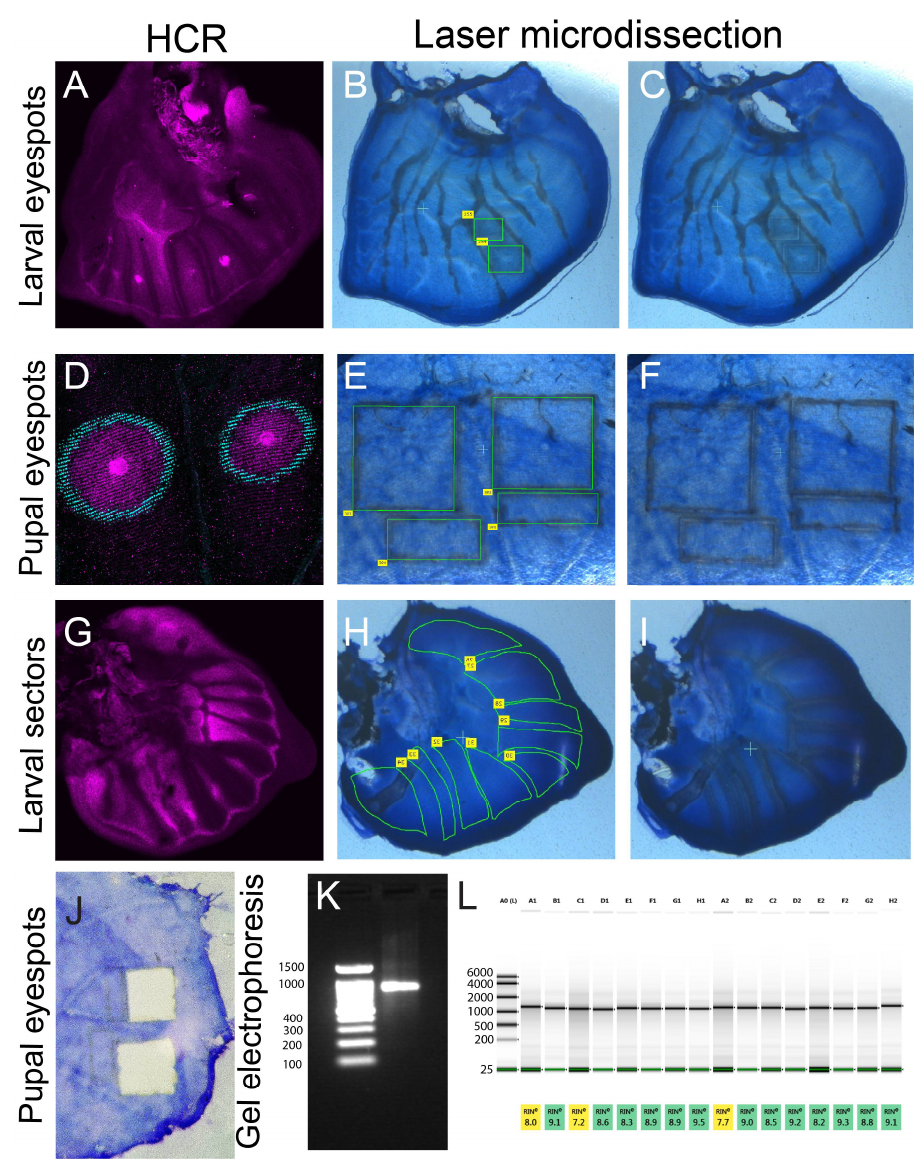
Figure 3. Laser microdissection of larval and pupal wings. ( A ) Larval wings showing the expression of the gene spalt in the center of the eyespots (visualized with a hybridization chain reaction). ( B , C ) Panel A is used as a reference to localize the position of the eyespot center in a wing at a similar developmental stage ( B , C ) and to perform the microdissections. ( D ) Pupal wing, expressing the genes spalt (magenta) and optix (cyan) in the rings of the eyespots (hybridization chain reaction) is used as a reference to localize the position of the eyespots in a wing at a similar developmental stage ( E , F ) to perform microdissections. ( G ) Larval wing showing expression of the gene spalt in the different sectors of the wings (hybridization chain reaction) is used as a reference to localize the positions of the wing sectors along with the venation pattern on a wing at a similar developmental stage ( H , I ) to perform microdissections for sector-specific transcriptomes. ( J ) A pupal wing with the eyespot regions removed with a pair of fine tweezers. ( K ) An agarose gel electrophoresis on the RNA extracted from laser-dissected wing tissue with a clear band of RNA. ( L ) RIN value of different RNA samples from the larval eyespot and control regions from wet season (WS) and dry season (DS) forms of B. anynana butterflies. A0: ladder; A1, C1, E1, G1: WS control; A2, C2, E2, G2: DS control; B1, D1, F1, H1: WS eyespot; B2, D2, F2, H2: DS eyespot. Green line: lower marker. The samples were sent for RNA-seq and the gel image was generated from Azenta,